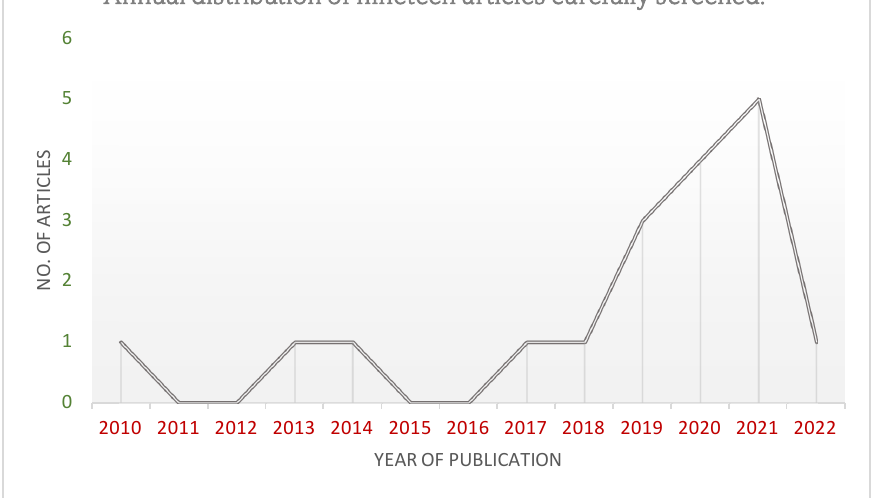
Figure 3. Annual distribution of the 19 articles that were carefully screened.